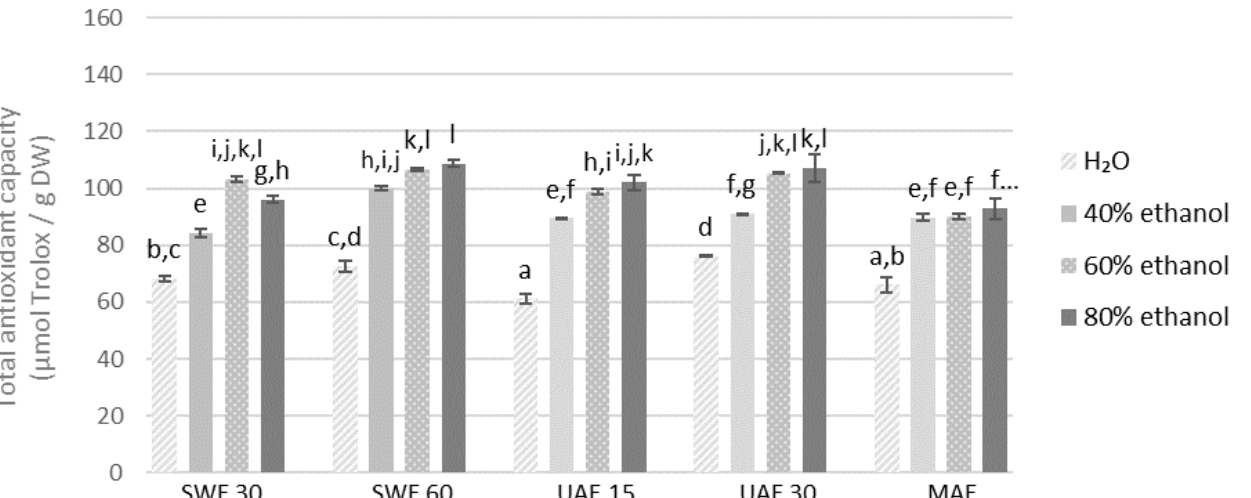
Figure 6. Antioxidant capacity of the extracts obtained from the fraction with particle size 0.5–1.25 mm determined by the method with DPPH radicals. SWE—shaking water bath extraction; UAE—ultrasound-assisted extraction; MAE—microwave assisted extraction; 15, 30 or 60-time of extraction. Results are presented as the mean ± SD from triplicate determinations. Different letters: a, b, c, d, e, f, g, h, i, j, k, l indicate that samples are significantly different. The letter “a” marks the lowest value. Higher values are marked with consecutive letters of the alphabet. Bars that share the same letter within the group are not significantly different according to Tukey’s HSD test at p > 0.05.